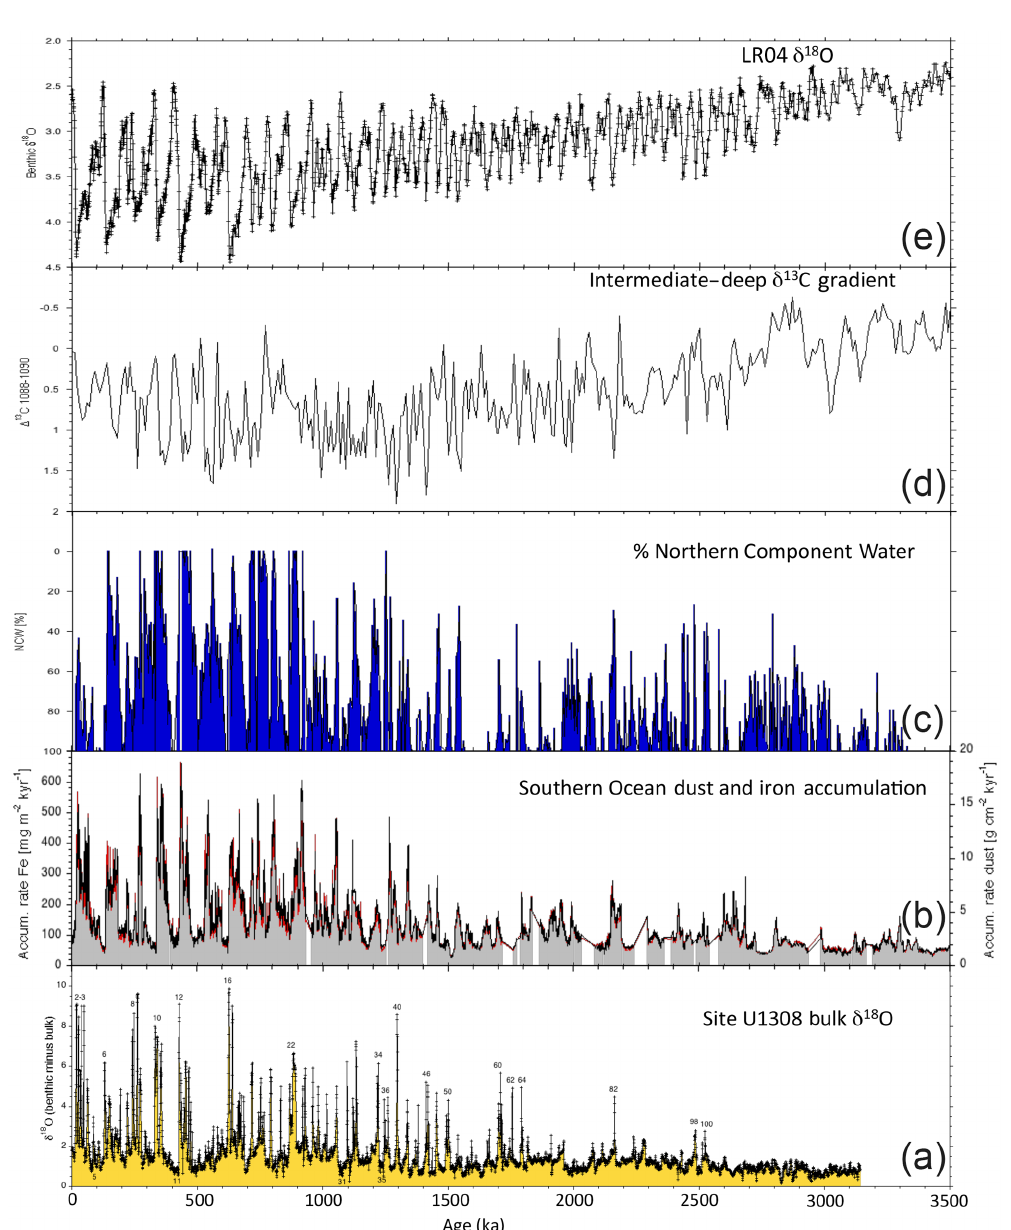
Figure 9. (a) The difference between benthic and bulk carbonate δ 18 O at Site U1308. (b) Iron (red) and dust (black) accumulation at ODP Site 1090 in the South Atlantic (Martinez-Garcia et al., 2011). (c) % Northern Component Water estimated by intra-basinal carbon isotope gradients (Lang et al., 2016). (d) The carbon isotope gradient between intermediate and deep water ( (cid:49) 13 C ID ) in the Southern Ocean (Hodell and Venz, 2006). (e) The LR04 benthic δ 18 O record (Lisiecki and Raymo,